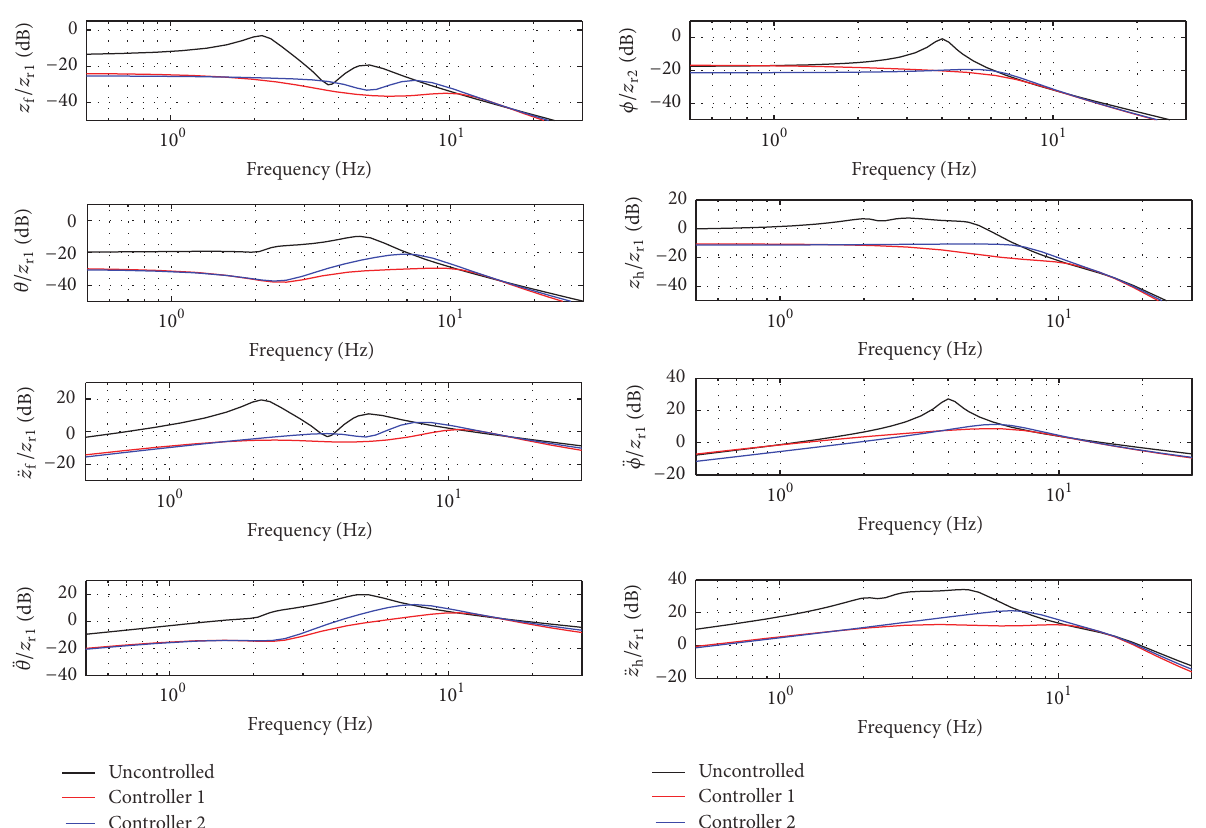
Figure 12: Controlled and uncontrolled frequency